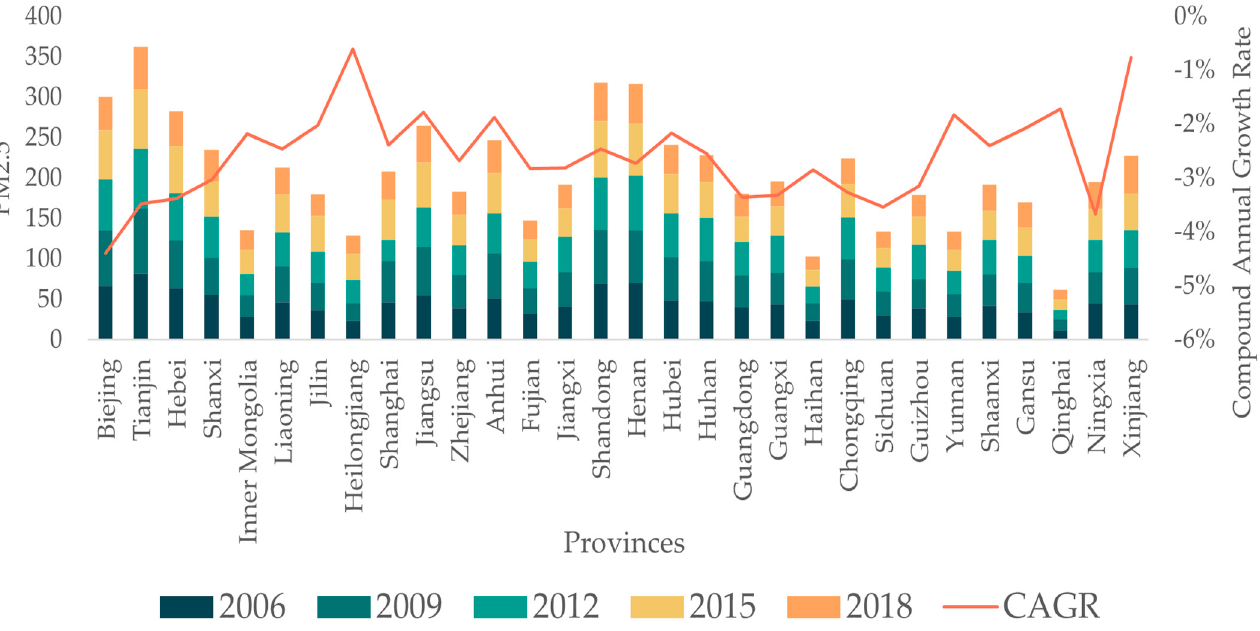
Figure 3. Temporal trends of PM 2.5 and its average annual growth rate in 30 provinces (autonomous regions and municipalities).